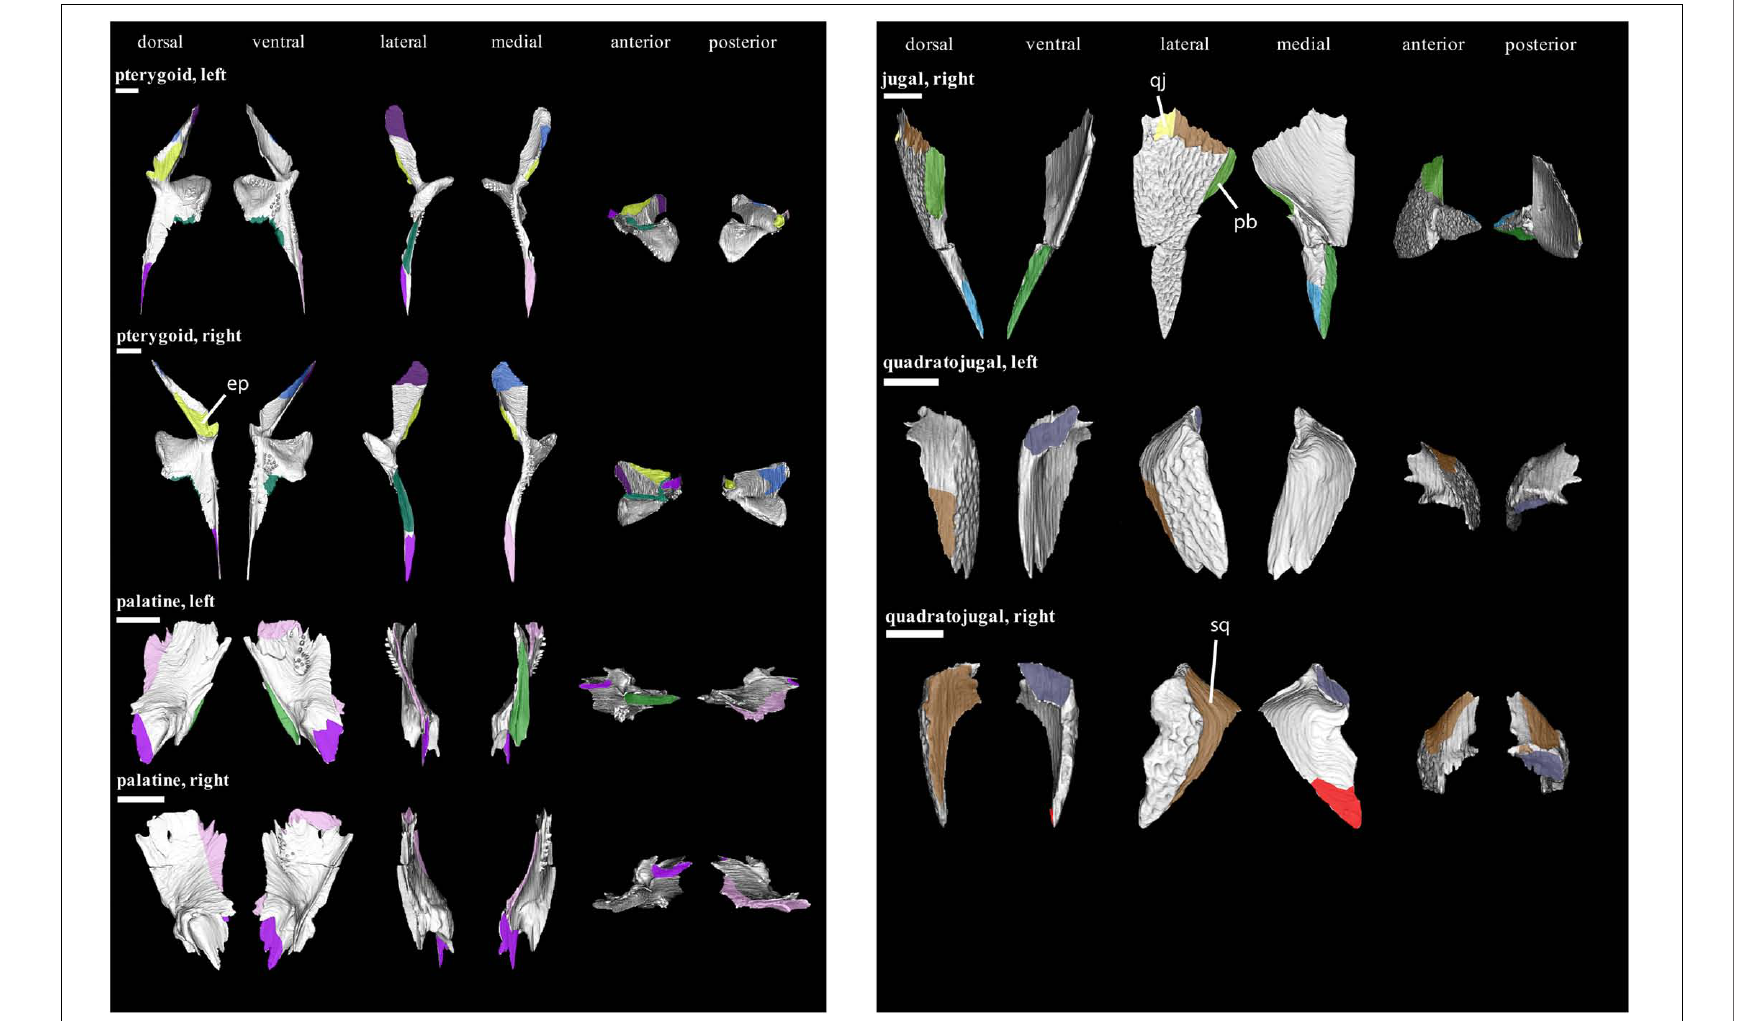
FIGURE 7 | Isolated bones in dorsal, ventral, lateral, medial, anterior and posterior views. Articulation areas with other bones are colored. Left and right pterygoid, left and right palatine, right jugal, and left and right quadratojugal are shown. Scale bar = 10 mm. For abbreviations see caption to Figure 1